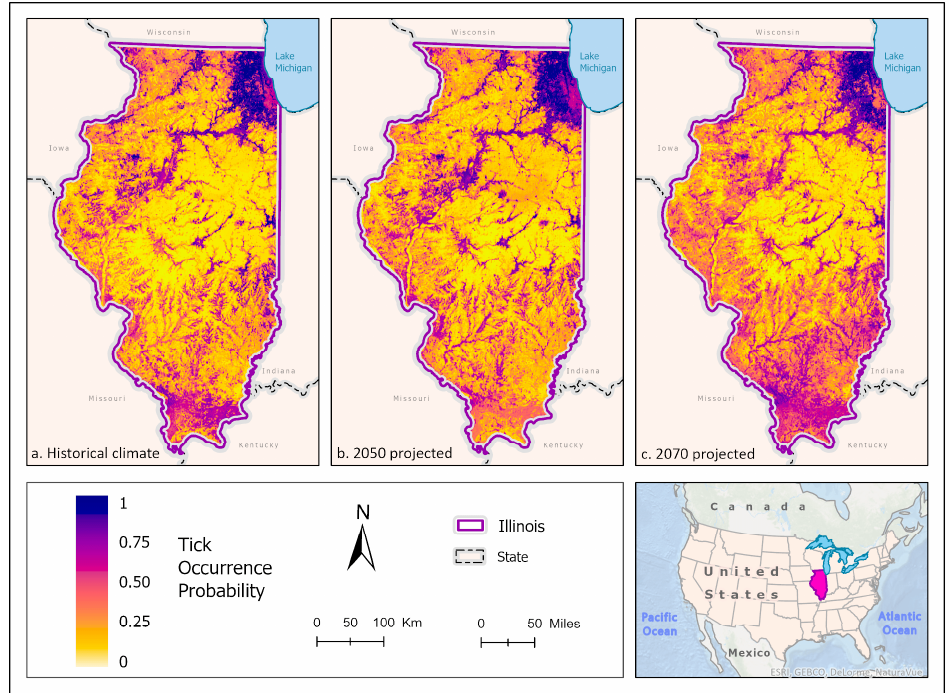
Figure 2. ( a ) Mean-weighted ensemble prediction of the probability of I. scapularis occurrence in Illinois under historical climate conditions. ( b ) Mean-weighted ensemble of predicted probability